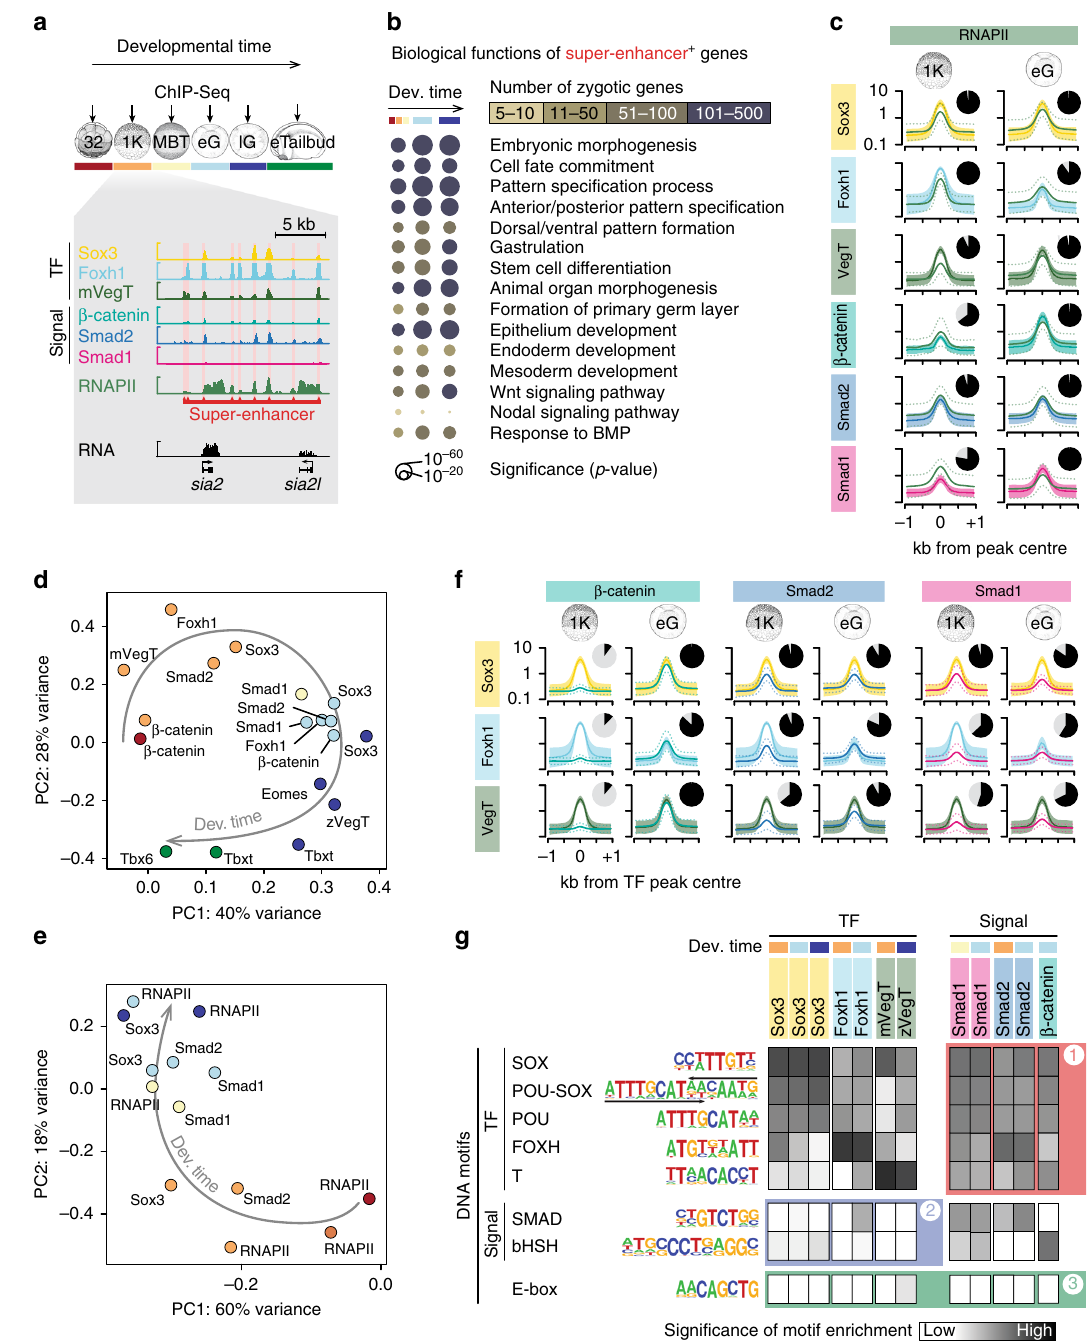
signal mediators, we note that, fi rst, Smads and/or β -catenin were frequently detected at Sox3, Foxh1 or VegT binding sites (top 2000 peaks shown in Fig. 3f) and, second, Smad- and/or β - catenin-bound pCRMs (top 2000 peaks) were signi fi cantly enriched for SOX, POU-SOX, POU, FOXH and T motifs (red fi eld #1 in Fig. 3g) suggesting that corresponding TFs affect the recruitment of these signal mediators. The reverse was much less the case as shown by the low signi fi cance of SMAD and bHSH motif enrichments at TF-bound pCRMs (with the exception of Smad2-interactor Foxh1 24 ) (blue fi eld #2 in Fig.